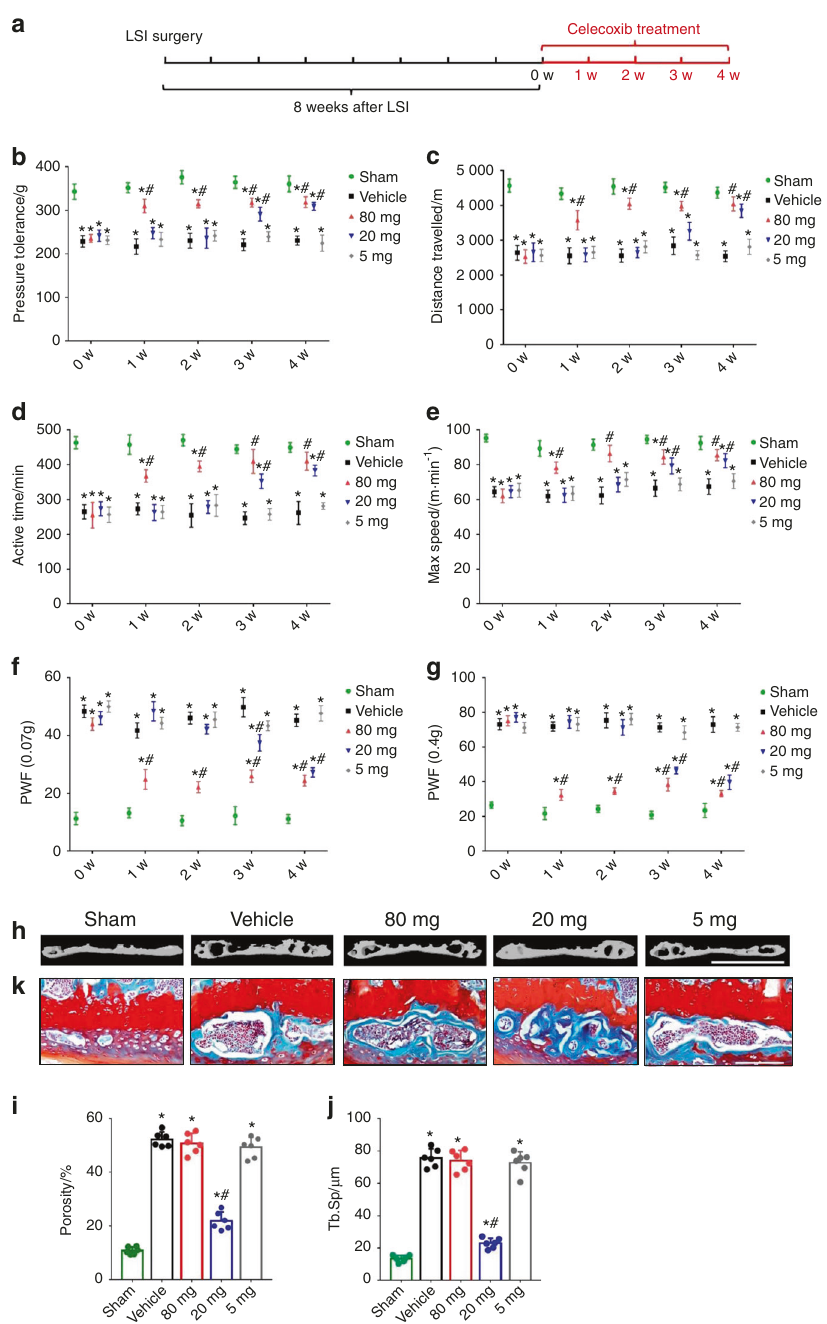
Fig. 1 Low-dose celecoxib reduced spinal pain by modifying endplate porosity in the mice with LSI. a Different dosages of celecoxib (very low dose, 5 mg·kg − 1 per day; low dose, 20 mg·kg − 1 per day; and high dose, 80 mg·kg − 1 per day) were administered intragastrically in mouse models of lumbar spine instability for 1 – 4 weeks. b Vocalization thresholds of the mice with LSI surgery at 0 – 4 weeks after celecoxib or vehicle treatment. Spontaneous activity results, including distance traveled ( c ), active time per 24 h ( d ), and maximum speed ( e ). f , g PWF by the von Frey test (0.07 g and 0.4 g). h Representative μ CT images of the L4-L5 caudal endplates at 4 weeks after celecoxib or vehicle treatment. Scale bars, 1 mm. Quantitative analysis of the total porosity ( i ) and trabecular separation ( j ) of the L4-L5 caudal endplates based on the μ CT images. * P < 0.05 compared with the sham group and # P < 0.05 com p ared with the vehicle group at the corresponding time points. n = 6 per group. k Representative safranin O and fast green staining images of the L4-L5 caudal endplate sections at 4 weeks after celecoxib or vehicle treatment. Scale bars, 50 μ Low-dose celecoxib reduced endplate porosity by modulating with qRT-PCR and immunostaining of Vpp3 for osteoclast function skeletal interoception (Fig. 3h – j). These fi ndings indicated that low-dose celecoxib PGE2, which can be produced by osteoblastic cells, activates EP4 (20 mg·kg − 1 per day) may promote new bone formation in porous receptors on sensory nerves to induce bone formation, which vertebral endplates to reduce porosity.